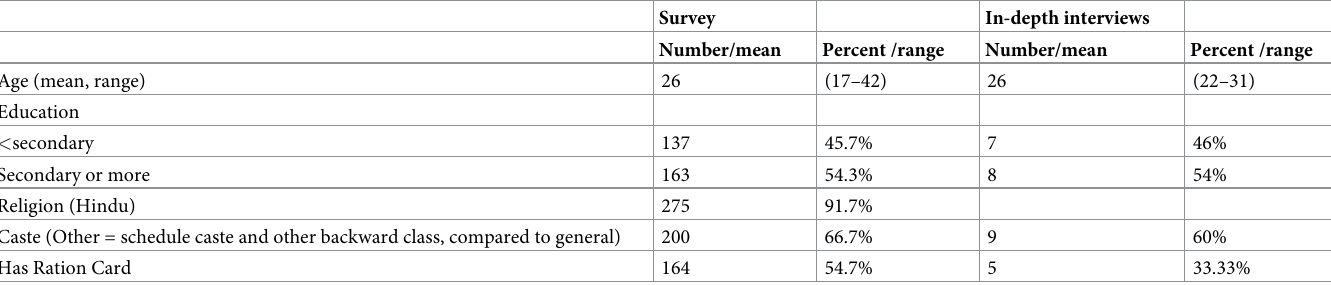
Table 1. Demographics of the